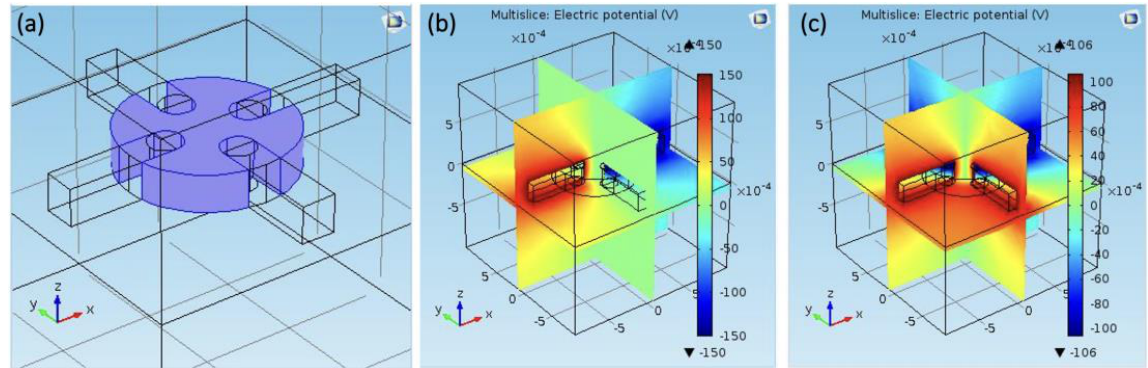
Figure 3. Electric potential distribution on 3D scale. ( a ) Geometry of the simulation electrodes. ( b,c ) Electrical potential distribution for two different voltage configurations with voltage applied across different electrodes (length unit: m).